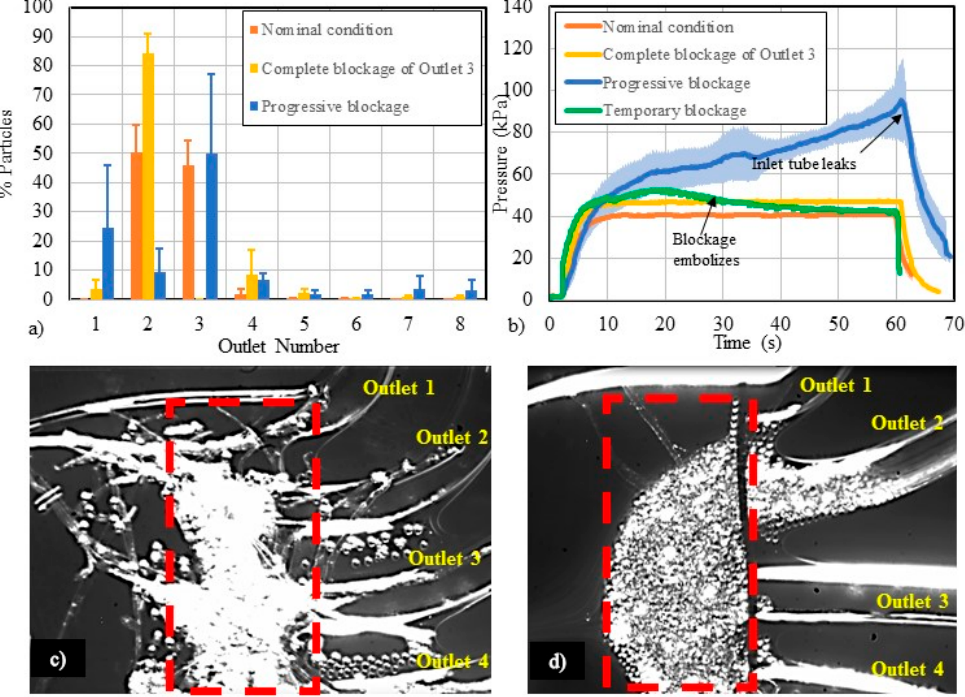
Figure 5. ( a ) The particle distribution profiles of 16- µ m particles collected at 5000 µ L / min due to di ff erent types of channel blockages. Error bars represent standard deviations from triplicate tests. ( b ) A pressure study for di ff erent cases of channel contamination / blockages was conducted at 500 µ L /